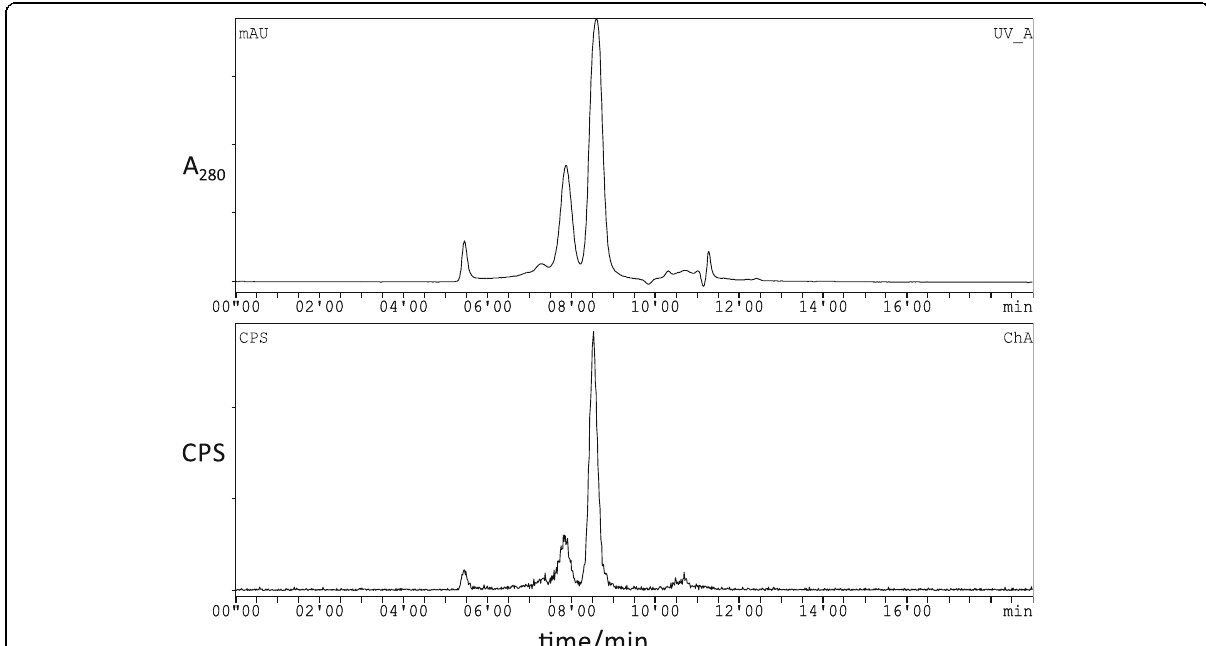
Fig. 2 Size-exclusion HPLC of THP-mal-J591-scFv after radiolabelling with gallium-68 (SEC-2000, column, flow rate 1 ml/min, UV detection at 280 nm). Top: UV chromatogram, showing THP-mal-J591-scFv eluting at ca. 8.5 min and its non-covalent or disulfide-bonded dimer eluting at 7.8 min; bottom: simultaneously recorded radiochromatogram, showing radioactivity associated with THP-J591c-scFv (8.5 min, 84%), dimer (7.8 min, 14%) and unbound gallium-68 (10 – 12 min, <2.6%). A small radioactive higher molecular weight protein was also observed (5.5 min,